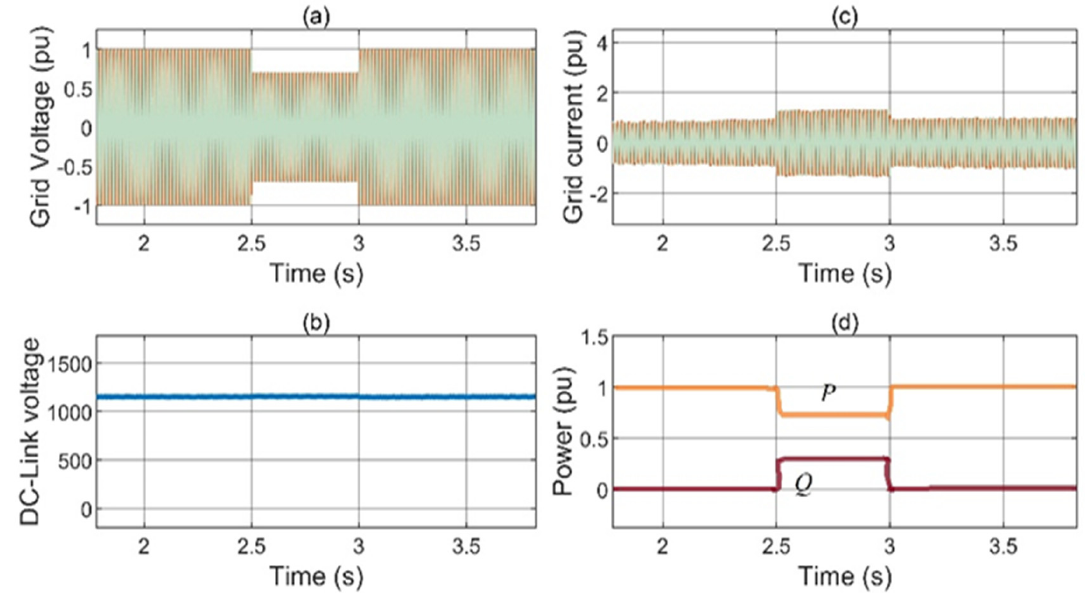
Figure 12. LVRT Performance of proposed scheme during symmetrical grid fault. ( a ) Grid voltage ( b ) Inverter current ( c ) DC-link voltage ( d ) Active and Reactive power.